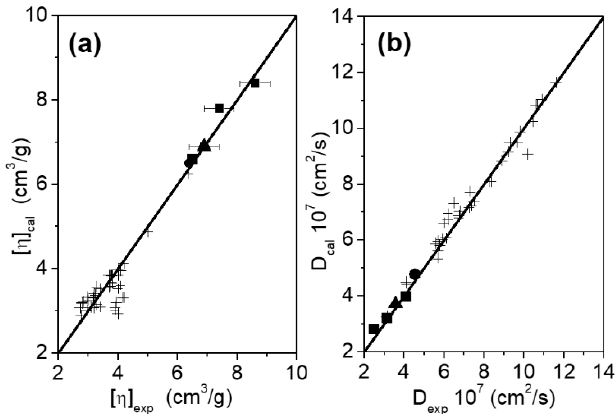
Figure 6. Comparison between calculated and experimental values of ( a ) intrinsic viscosity and ( b ) translational diffusion coefficient of the systems under study, ( (cid:4) ) TZM and complexes, ( • ) g-eHER2 monomer [19] and ( (cid:78) ) g-eHER2 dimer [19], and (+) mono and multimeric globular proteins taken from the literature [34,45,46].